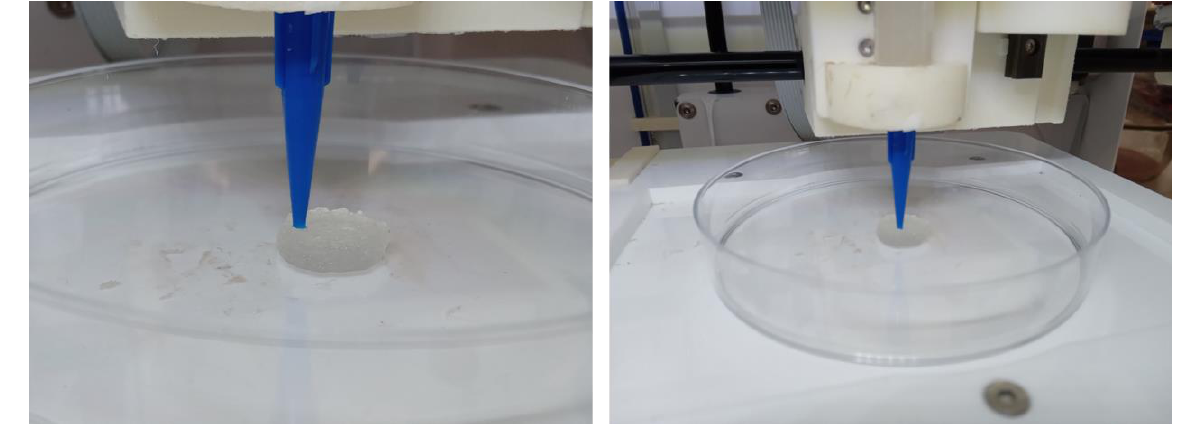
( e ) Figure 8. Physical illustration of: ( a ) Rotating Lever; ( b ) Piston with seal; ( c ) Shell; ( d ) Shell Connec- tion; ( e ) Shell Split. 3.2. Semi-Solid Extrusion 3D Printing of the Microgel Sodium alginate hydrogels were selected as a model mechanoresponsive [28] mate- rial. These hydrogels are composed of a continuous three-dimensional polymeric matrix and an aqueous phase. The mechanoresponsive nature of these gels renders them able to release part of the aqueous phase upon mechanical stimulation without compromising their structure (for low applied external force). To perform in this mechanoresponsive way, these gels should be partially crosslinked to be able to be printed, and subsequently they should be fully crosslinked to become solid. These solid forms are expected to release only part of their aqueous phase (aqueous solutions) suitable for injection. Such a system can be the drug loading carriers. The 3D printing of sodium alginate gels was performed according to the literature, with modification [29,30]. Briefly, 5 mL of a 4% w / v aqueous solution of sodium alginate (Sigma Aldrich ® , Merck KGaA, Darmstadt, Germany) was mixed with 0.4 mL of 10% w / v aqueous solution of calcium chloride (Sigma Aldrich ® ,